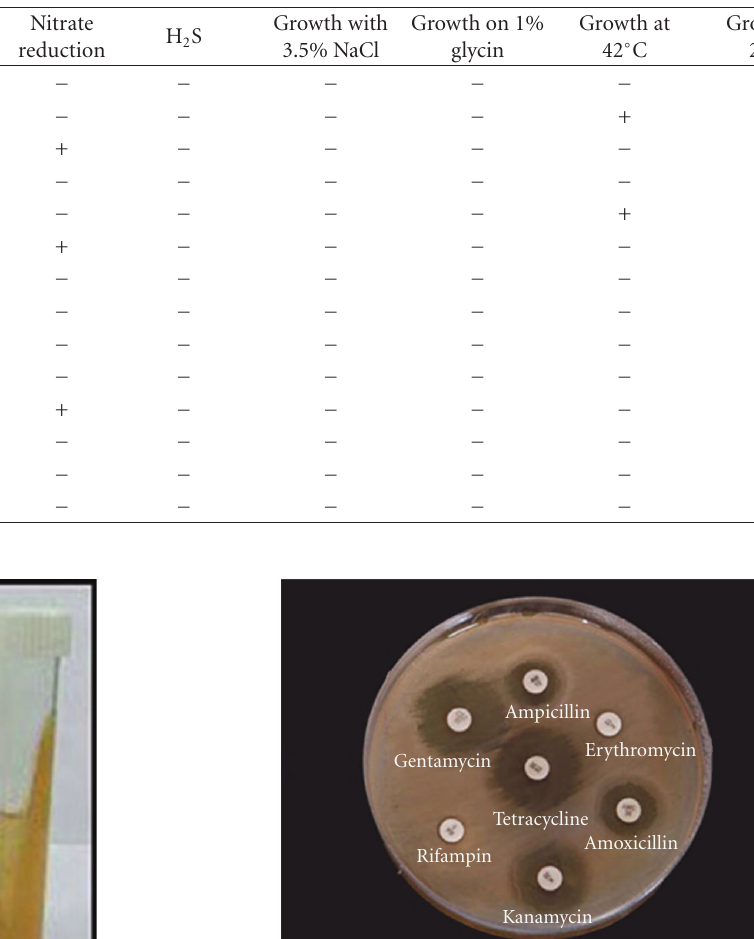
Table 1: Results of biochemical tests characterizing H. pylori isolates from 14 districts.